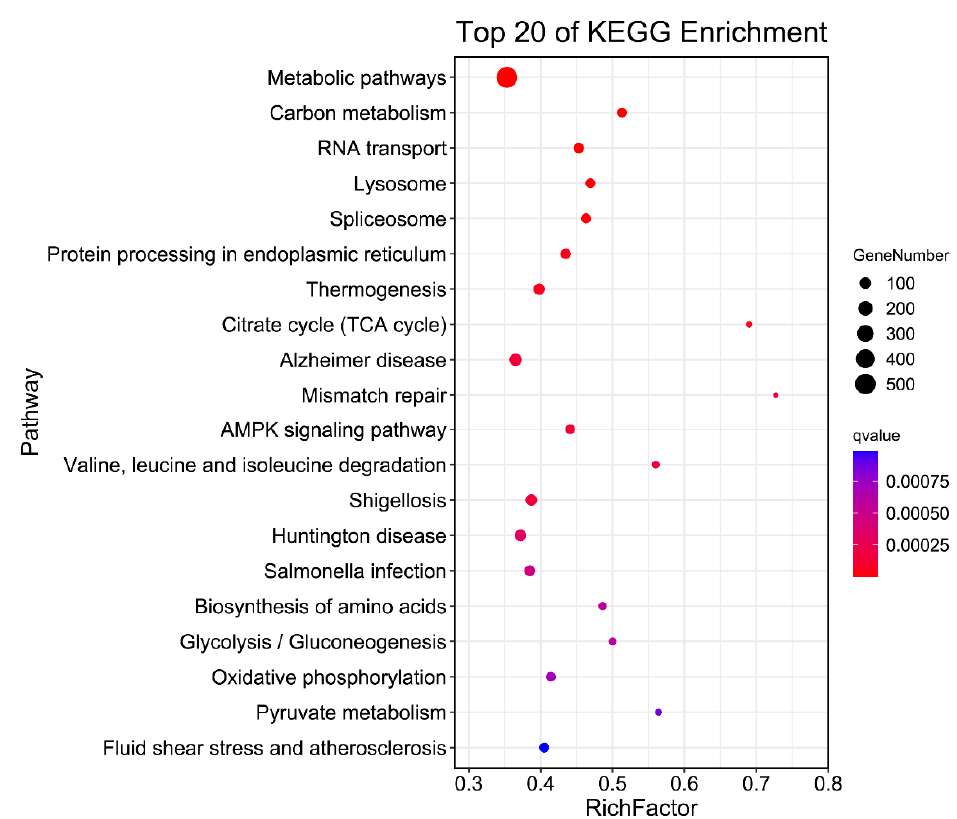
Figure 7. The Kegg enrichment analysis of genes in Sus scrofa . Scatter diagram of enrichment of genes with 2 or more than 2 PAS KEGG pathways. The X -axis shows the ratio of the number of annotated genes to the total pathway genes annotated, and the Y -axis shows the top 20 pathway names. The different color of dot indicates different value. The dot size indicates the gene number.